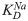
Kinetic model of Na+/H+ exchange.The exchanger can switch between an inside- (Ci) or outside-open (Co) conformation only as long as one of the substrates (H+ or Na+) is bound. Binding of substrates is described by the constants pK and KDNa. Substrate translocation occurs with the rate constants k1 (for the translocation of Na+) or k2 (for the translocation of H+). m and n denote Hill coefficients for the binding of H+ and Na+, respectively.